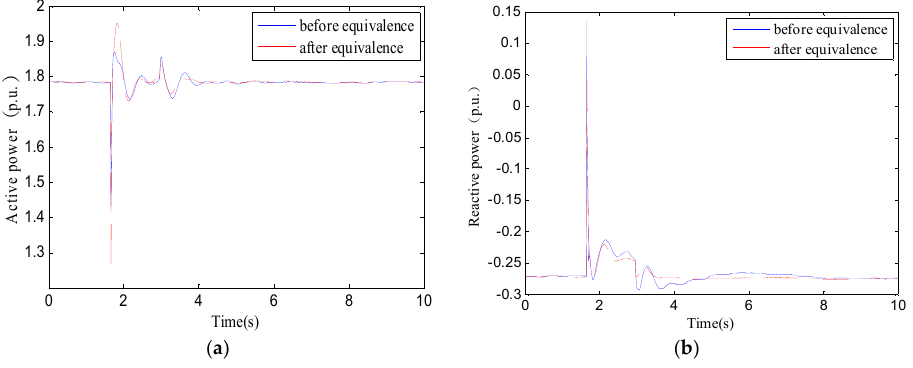
Figure 13. ( a ) Active power curves between before and after equivalence; ( b ) Reactive power curves.